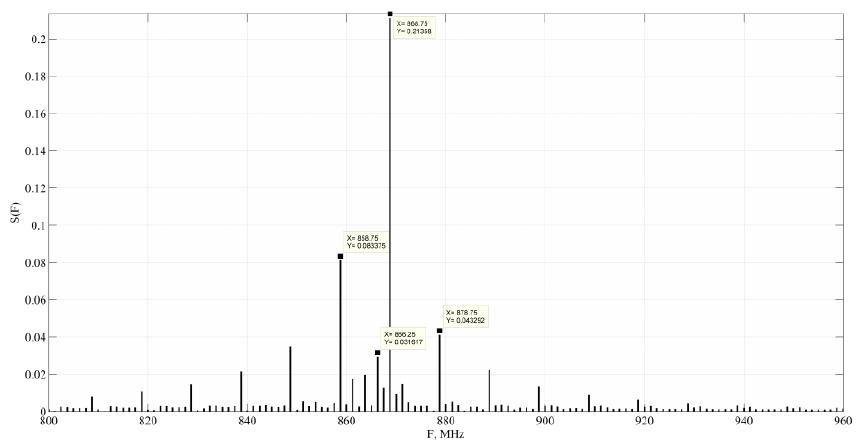
Fig. 6. Spectrum of the test sequence with